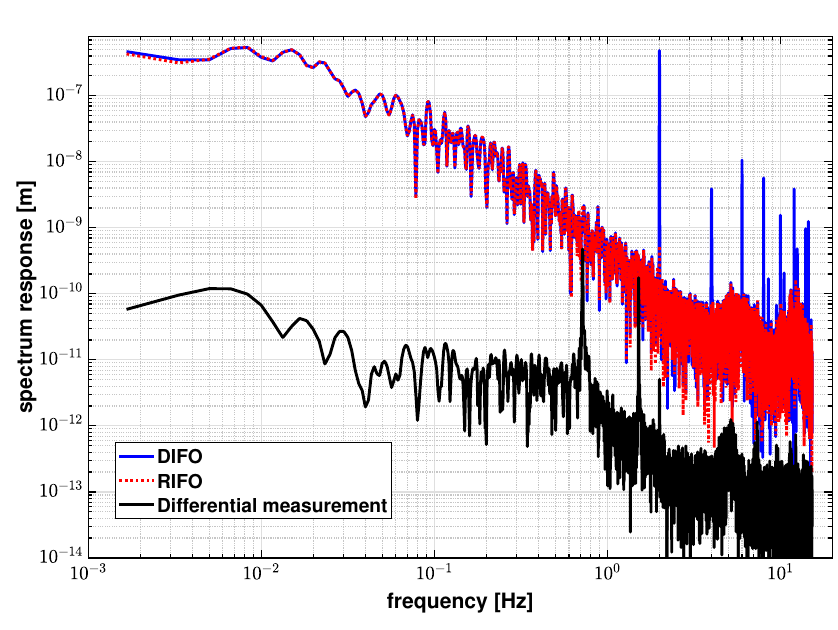
Figure 8. Linear spectra of DIFO, RIFO, and the differential measurement to the injected laser fre- quency noise by intentionally modulating the laser frequency at a rate of 2Hz. The spectrum response of DIFO to the laser frequency noise is 4.82 × 10 − 7 m while the RIFO response is 5.30 × 10 − 10 m at 2Hz. After performing the differential operation, the spectrum response is reduced to 5.07 × 10 − 12 m at